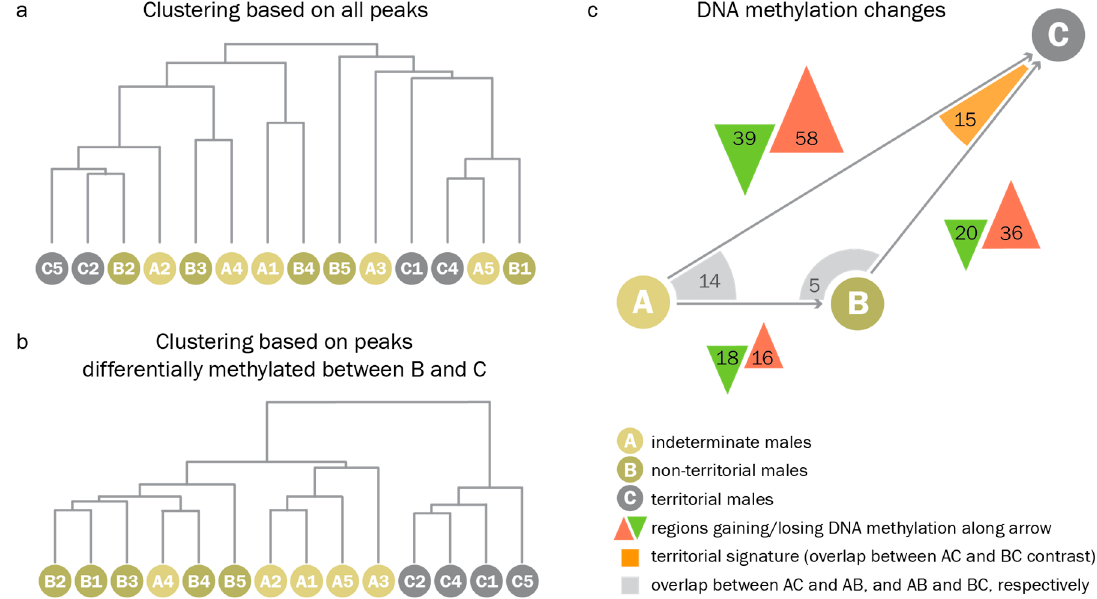
Figure 5. Indeterminate males do not display territorial DNA methylation patterns. ( a ). Clustering based on genome wide principal component analysis (PCA) eigenvalues based on read counts of all peak regions. Indeterminate, non-territorial, and territorial males are distributed randomly throughout the tree. ( b ). Clustering based on regions differentially methylated between non-territorial and territorial males. Branches for indeterminate, non-territorial, and territorial males cluster within the respective groups. Additionally, indeterminate males cluster with non-territorial males. ( c ). Results of pairwise comparisons. Green and red triangles represent regions that gain/lose DNA methylation during the transition represented by the grey arrow. Arrow lengths and triangle areas are drawn to scale to represent the number of regions with differential DNA methylation. Differentially methylated regions that overlap between two comparisons are indicated by orange/grey corners.